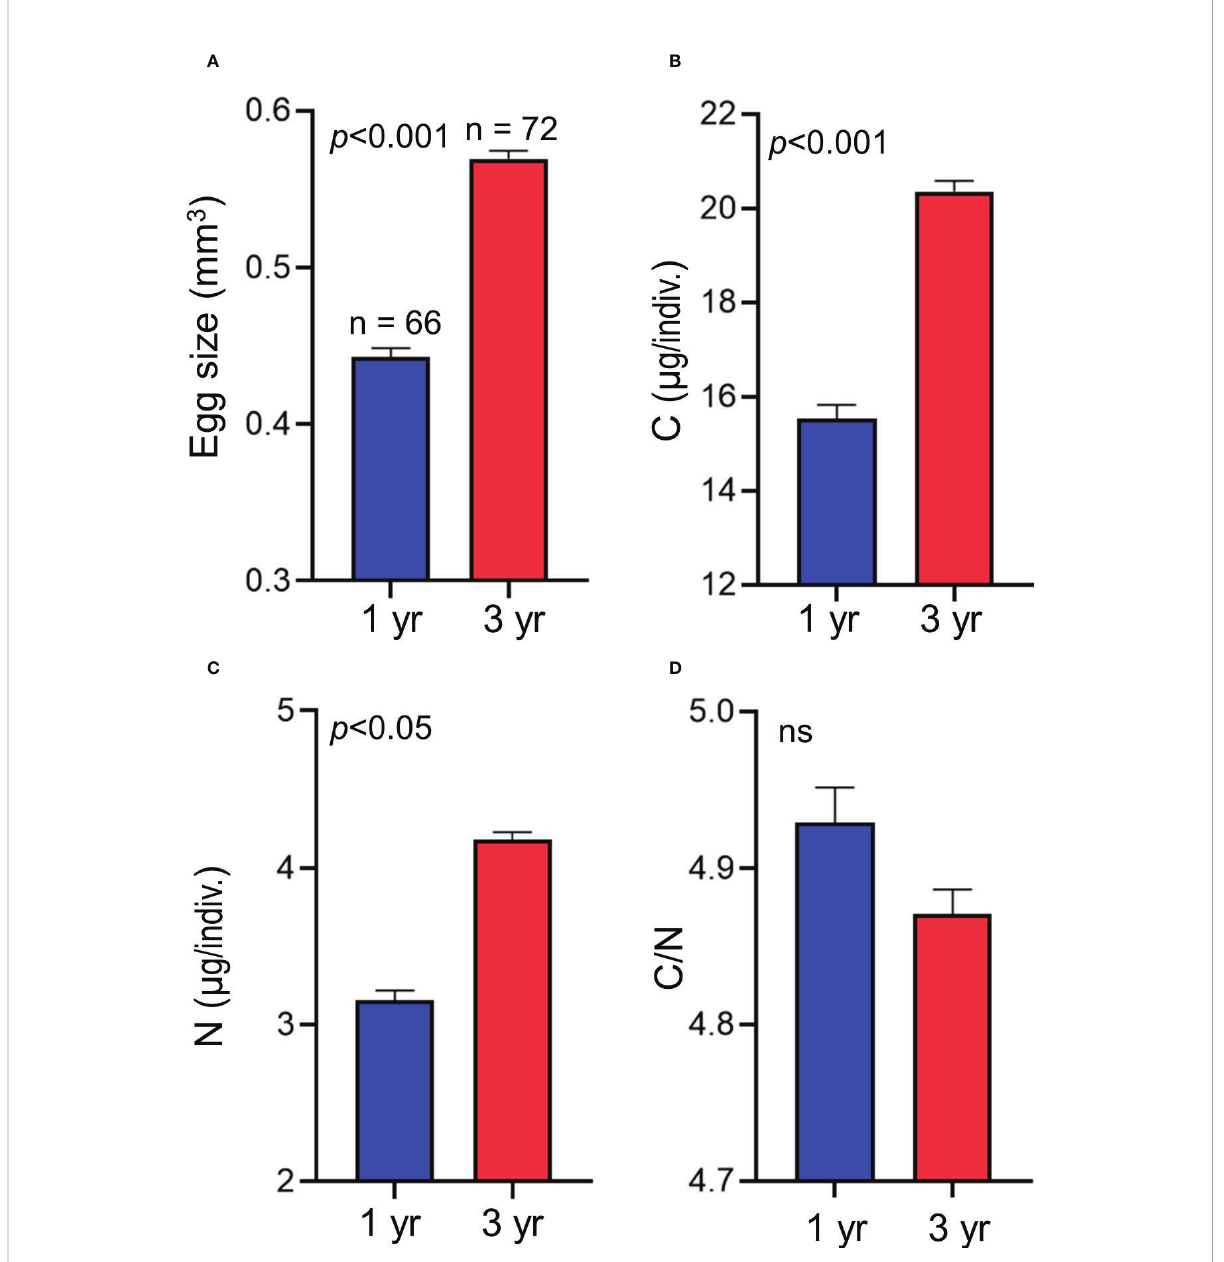
FIGURE 4 Mean size (A) , amounts of carbon (B) and nitrogen (C) , and carbon/nitrogen ratio (D) of each egg laid by 1- and 3-year-old chub mackerels at constant temperature (19°C). Result of comparison of value between the two age classes using linear mixed effect model is also shown. Numbers indicate the sample size. Data are shown as mean ±